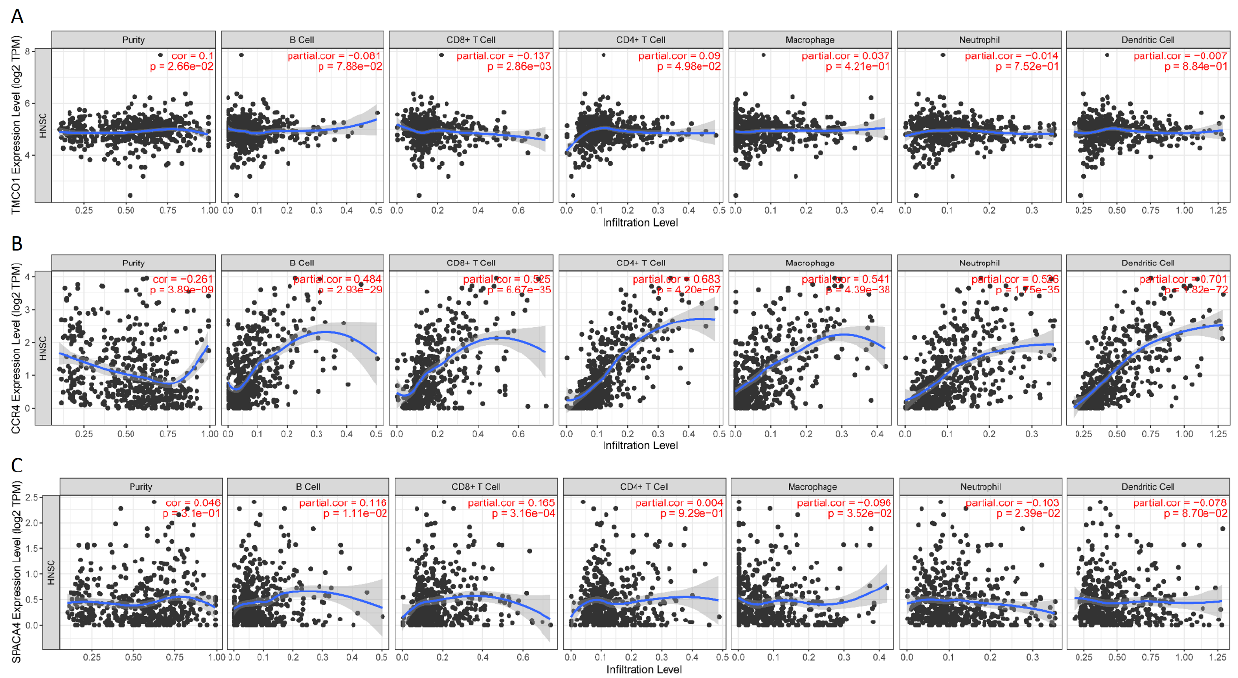
Figure 2. Identification of tumor antigens associated with antigen-presenting cells. Association of TMCO1 ( A ), CCR4 ( B ), SPACA4 ( C ) expression with the purity of infiltrating cells and numbers of B cells, CD8 + T cells, CD4 + T cells, macrophages, neutrophils, and dendritic cells in HNSCC.